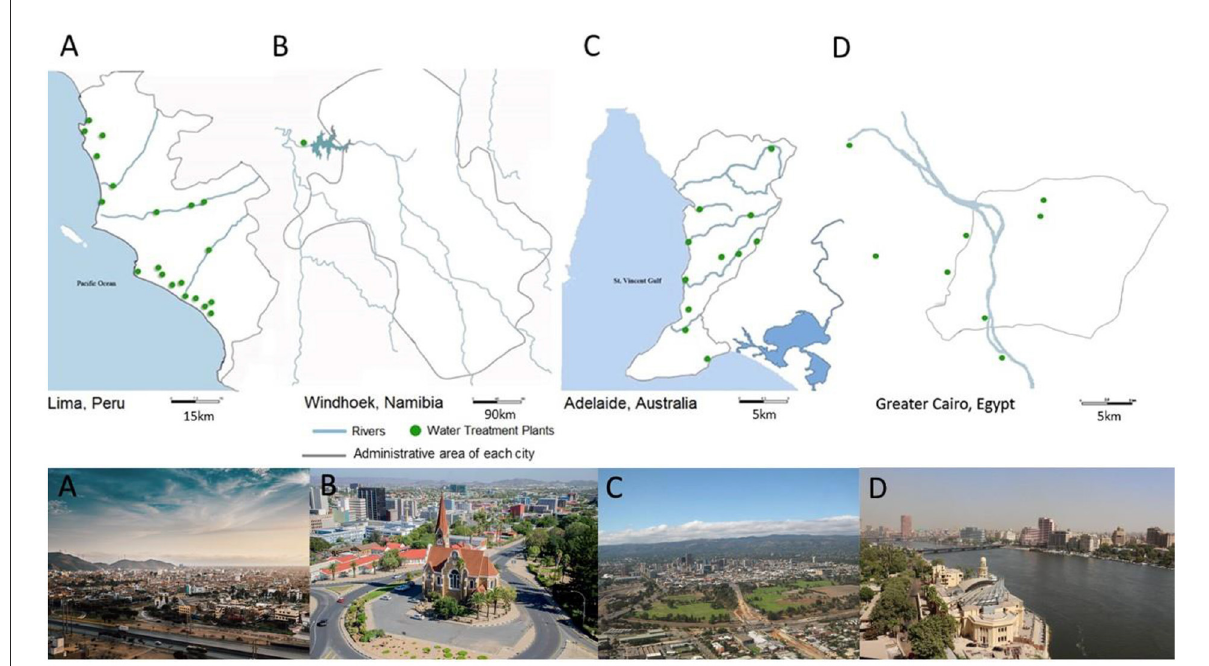
FIGURE3 Maps and photographic impressions of Lima (A) , Windhoek (B) , Adelaide (C), and Cairo (D) showing the administrative borders of each city, rivers, and water treatment plants in each. Sources of photos: Aarom Ore (A) from Unsplash, Dave Beaumont (C) from Flickr, wboroma (B) , and Remon Samuel (D) from